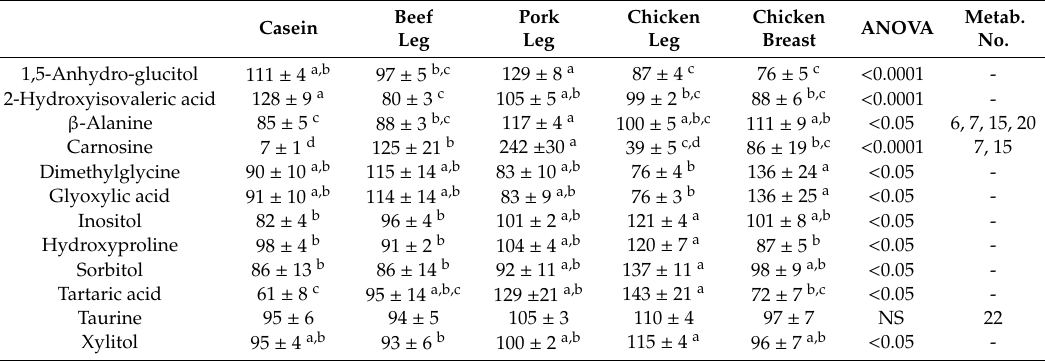
Table 2. E ff ects of dietary protein sources on metabolite levels in the liver of mice.